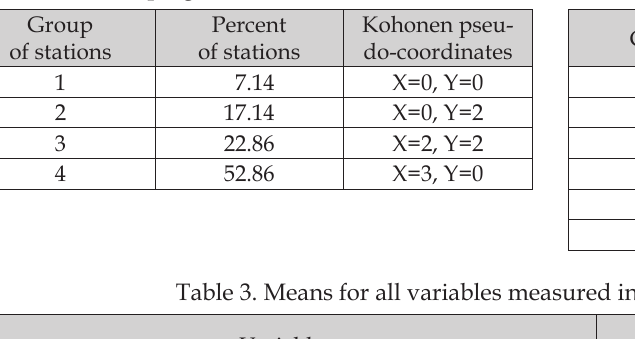
Table 4. Grouping of the second set of 8 stations.